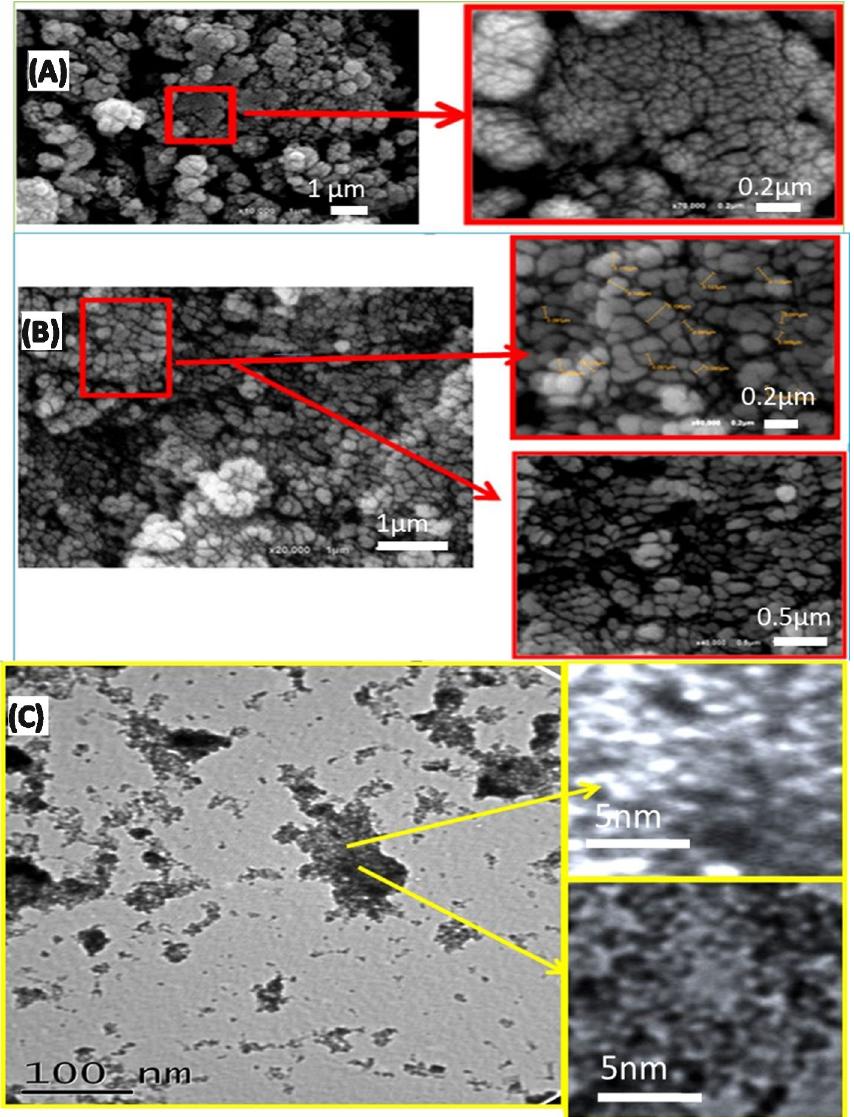
Figure 2. FE-SEM of Co–Cd–Fe LDH ( A ) and T-LDH/PbI 2 NC ( B ); and TEM images of nanocomposite ( C